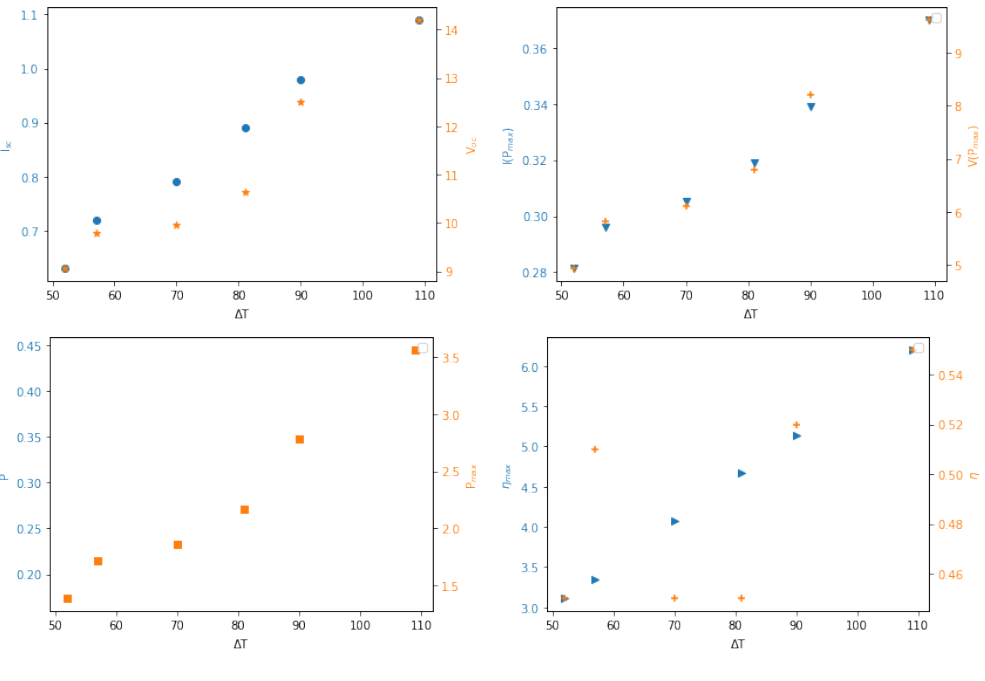
Figure 5. Values from the Tables 3 and 4.